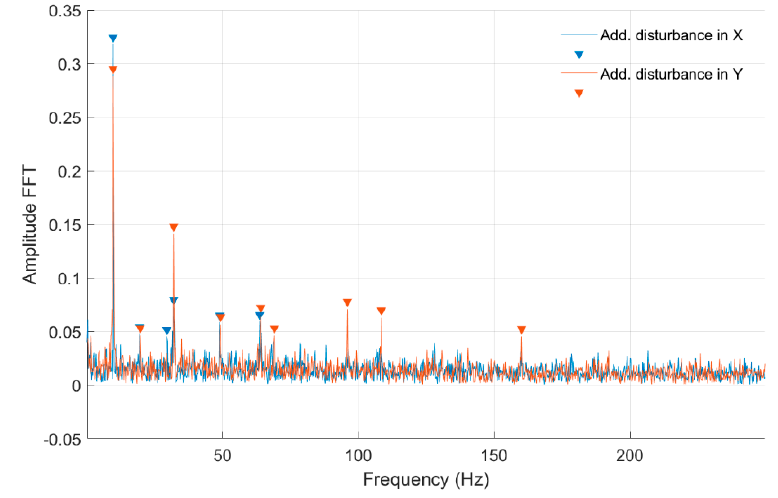
Figure 14. FFT of strain-level measurement for constant motor speed equal to 7 rev/s with disturbance from the control system for a quarter-bridge configuration (Node 954).